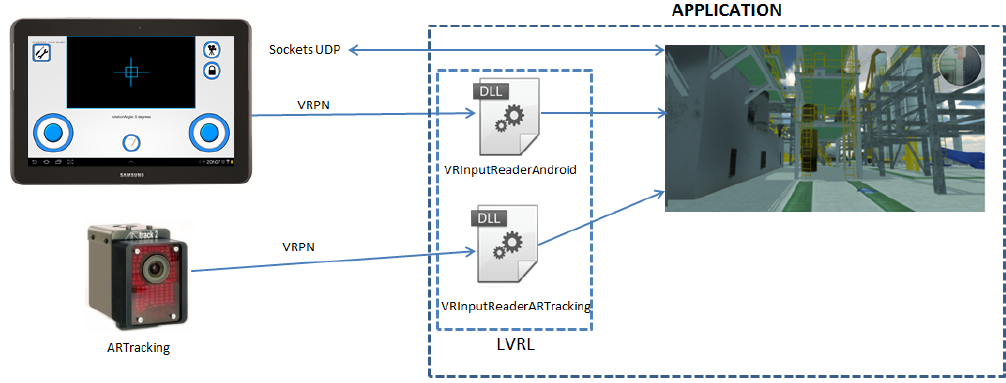
Figure 13. System architecture